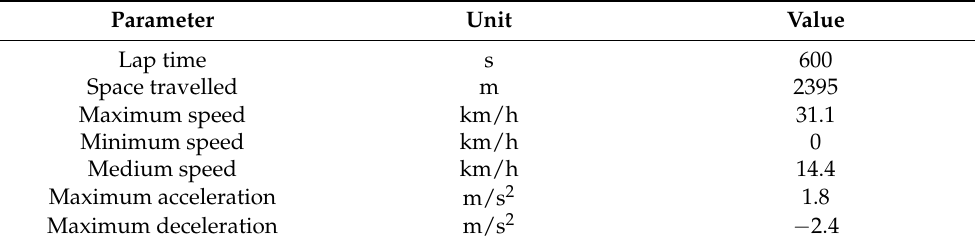
Table 2. Main information of the waste collection vehicle driving cycle.